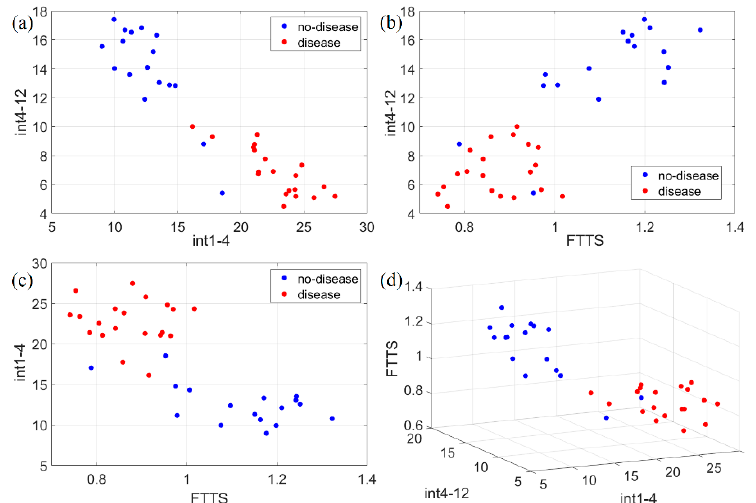
Figure 11. Scatter plots of the three identified movement features ( int1-4 , int4-12 , FTTS). Such fea- tures have been plotted in 2D and 3D to check separability in the following ways: ( a ) 2D represen- tation of int1-4 vs. int4-12 ; ( b ) 2D representation of FTTS vs. int4-12 ; ( c ) 2D representation of FTTS vs. int1-4 ; ( d ) 3D representation of the three adopted features for classification. Disease and no-disease cases are well separated, forming almost non-overlapping classes with respect to each feature.